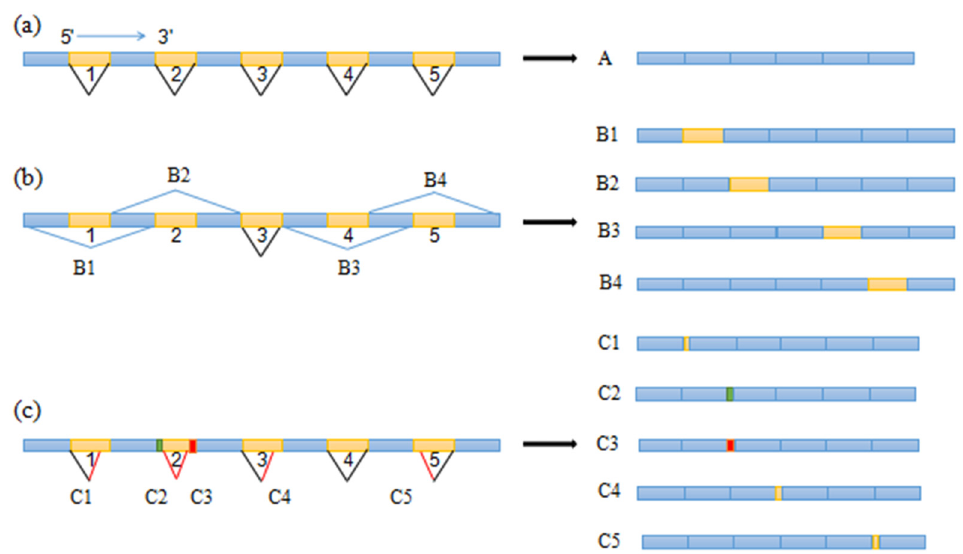
Figure 4. A schematic diagram showing the different types of AS events in the MAT1-1-10 gene. ( a ) Normal splicing. ( b ) Intron retention: B1, Retention of the first intron; B2, Retention of the second intron; B3, Retention of the fourth intron; B4, Retention of the fifth intron. ( c ) Alternative 5 ′ and 3 ′ splicing: C1, Alternative 3 (cid:48) splicing in the first intron; C2, Alternative 5 (cid:48) splicing in the second intron;